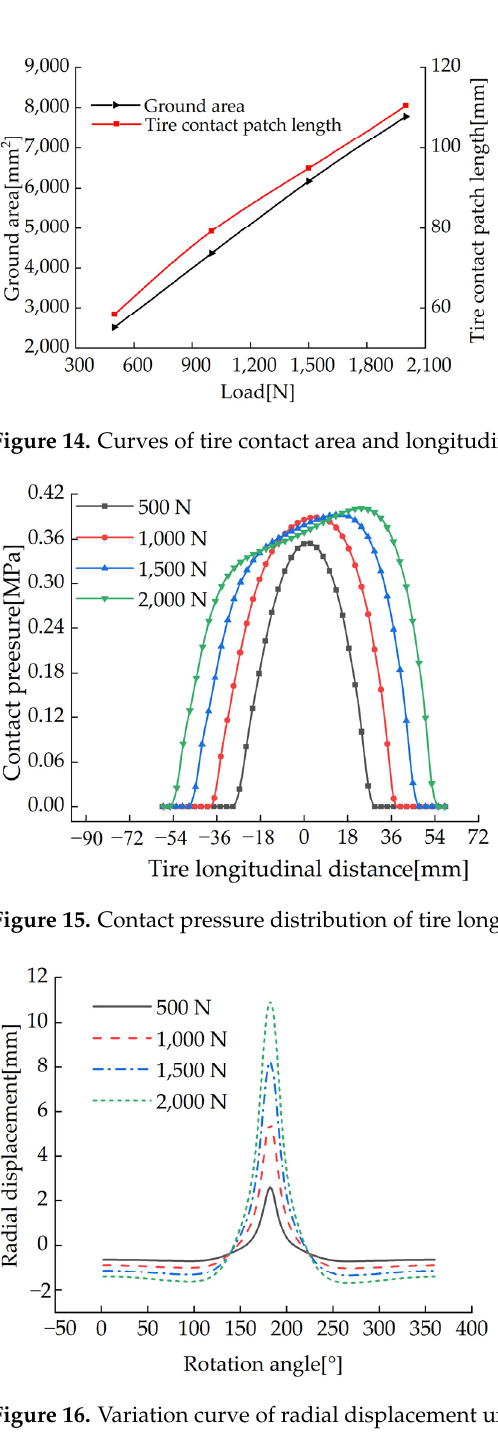
Figure 13. Contour map of tire contact pressure under different loads.